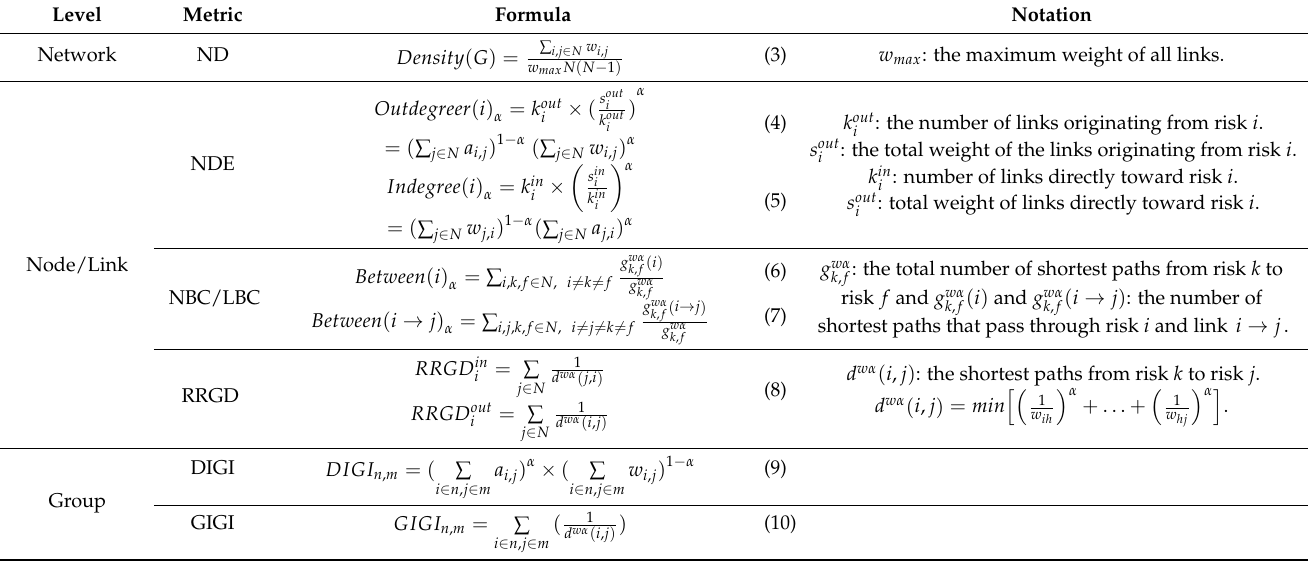
Table 3. Network